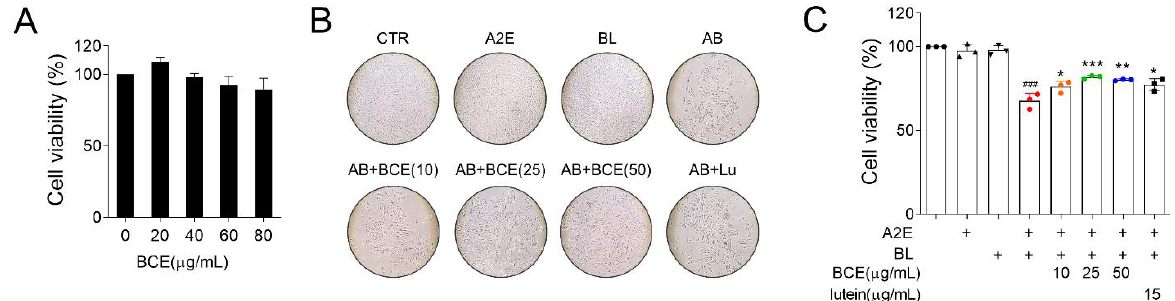
Figure 1. Protective effect of BCE against in vitro RPE damage model. ( A ) Effect of BCE on ARPE-19 cell viability. Cells were treated with BCE (20–80 µ g/mL) for 72 h. * p < 0.05 vs. CTR. ( B , C ) ARPE- 19 cells were treated with A2E three times at 48 h intervals, and 24 h after the last treatment, BCE (10–50 µ g/mL) was treated twice at 24 h intervals. After 30 min of BL irradiation, the cells were recovered for 24 h. Cells were monitored using the IncuCyte Zoom imaging system. Lutein (15 µ g/mL) was used as a positive control. The results are presented as the mean ± standard deviation of three independent experiments ( n = 3). ### p < 0.001 vs. CTR, * p < 0.05, ** p < 0.01, *** p < 0.001 vs. A2E + BL. CTR, no treatment control; A, A2E; BL, blue light; AB, A2E + BL; Lu, lutein (15 μg/mL); BCE (10), BCE, 10 μg/mL; BCE (25), BCE, 25 μg/mL; BCE (50), BCE, 50 μg/mL ; A2E, N -retinylidene- N -retinylethanolamine; BL, blue light; BCE, Blackcurrant extract.